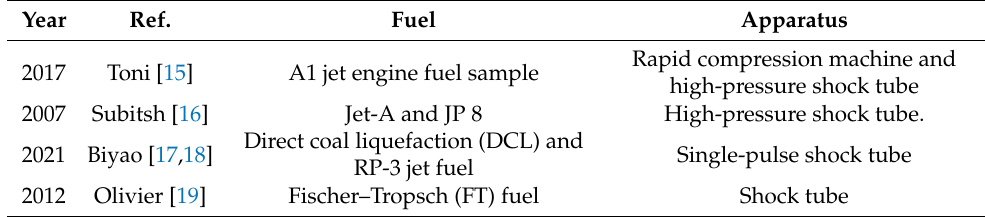
Table 1. Related research briefs on aviation